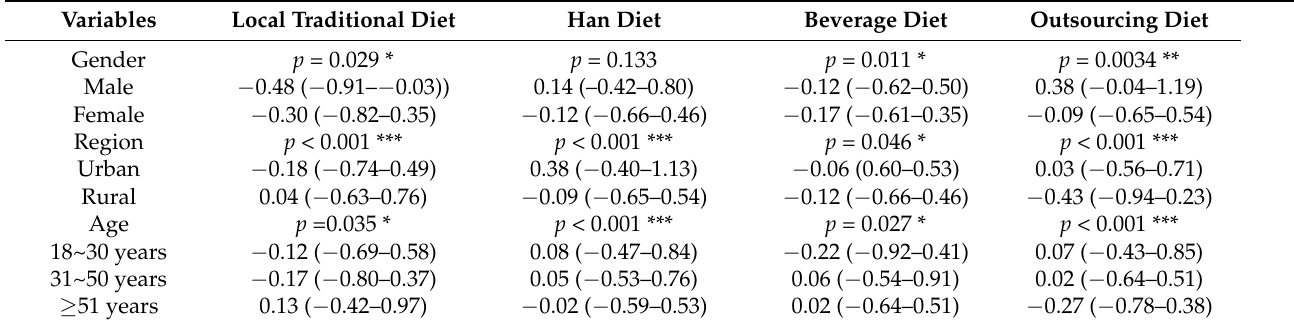
Table 2. The adherence scores to dietary patterns according to sociodemographic b